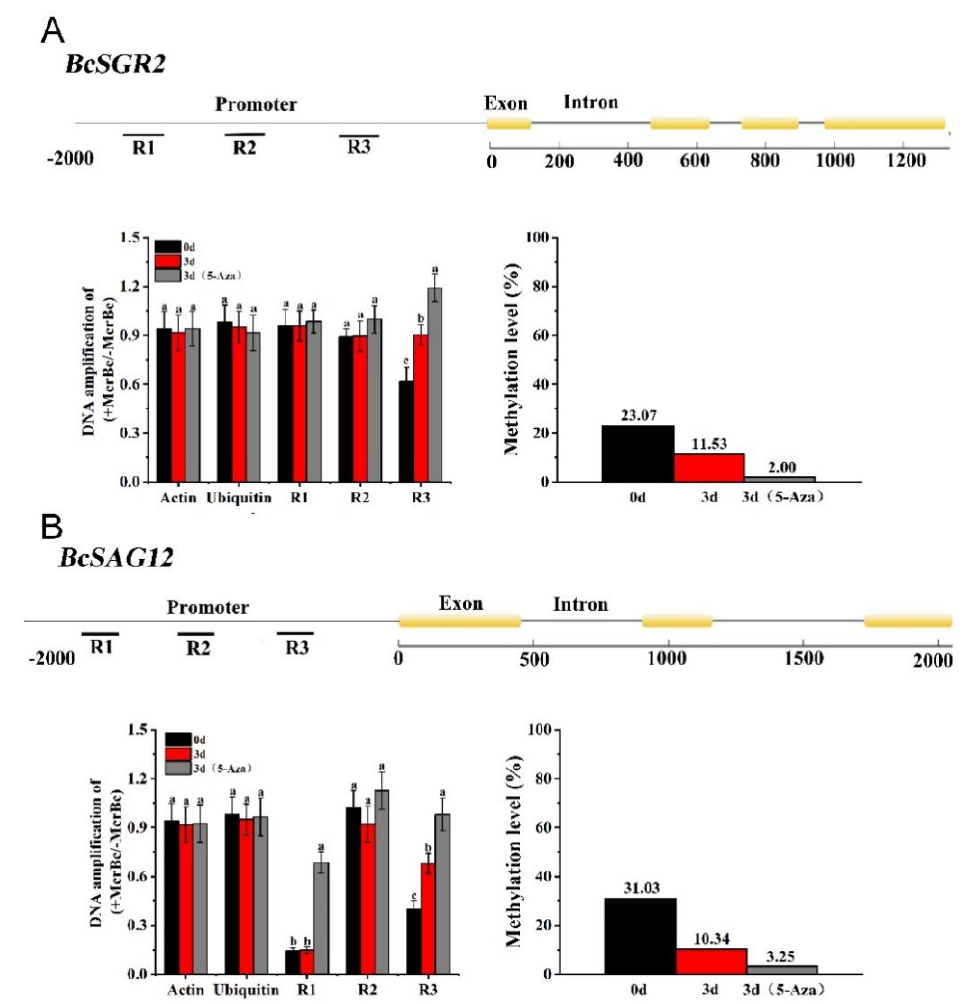
Figure 7. The degree of methylation of the Chl degradation gene ( BcSGR2 ) ( A ) and the senescence gene ( BcSAG12 ) ( B ) in the promoter regions R1, R2, and R3, and the methylation levels of BcSGR2 ( A ) and BcSAG12 ( B ) in the promoter R3 region at 0 d, 3 d, and 3 d (5-Aza) of storage. The data in the figure are the mean ± SD of three biological replicates. Different letters means statistically significant difference in the same same gene region ( p < 0.05).